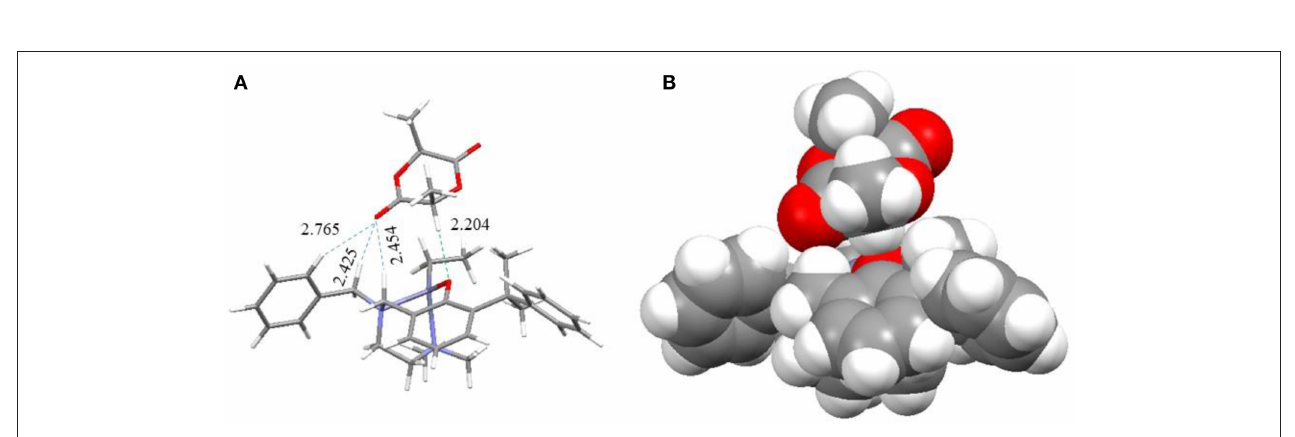
FIGURE 11 | The stick (A) and spacefill (B) model of intermediate I